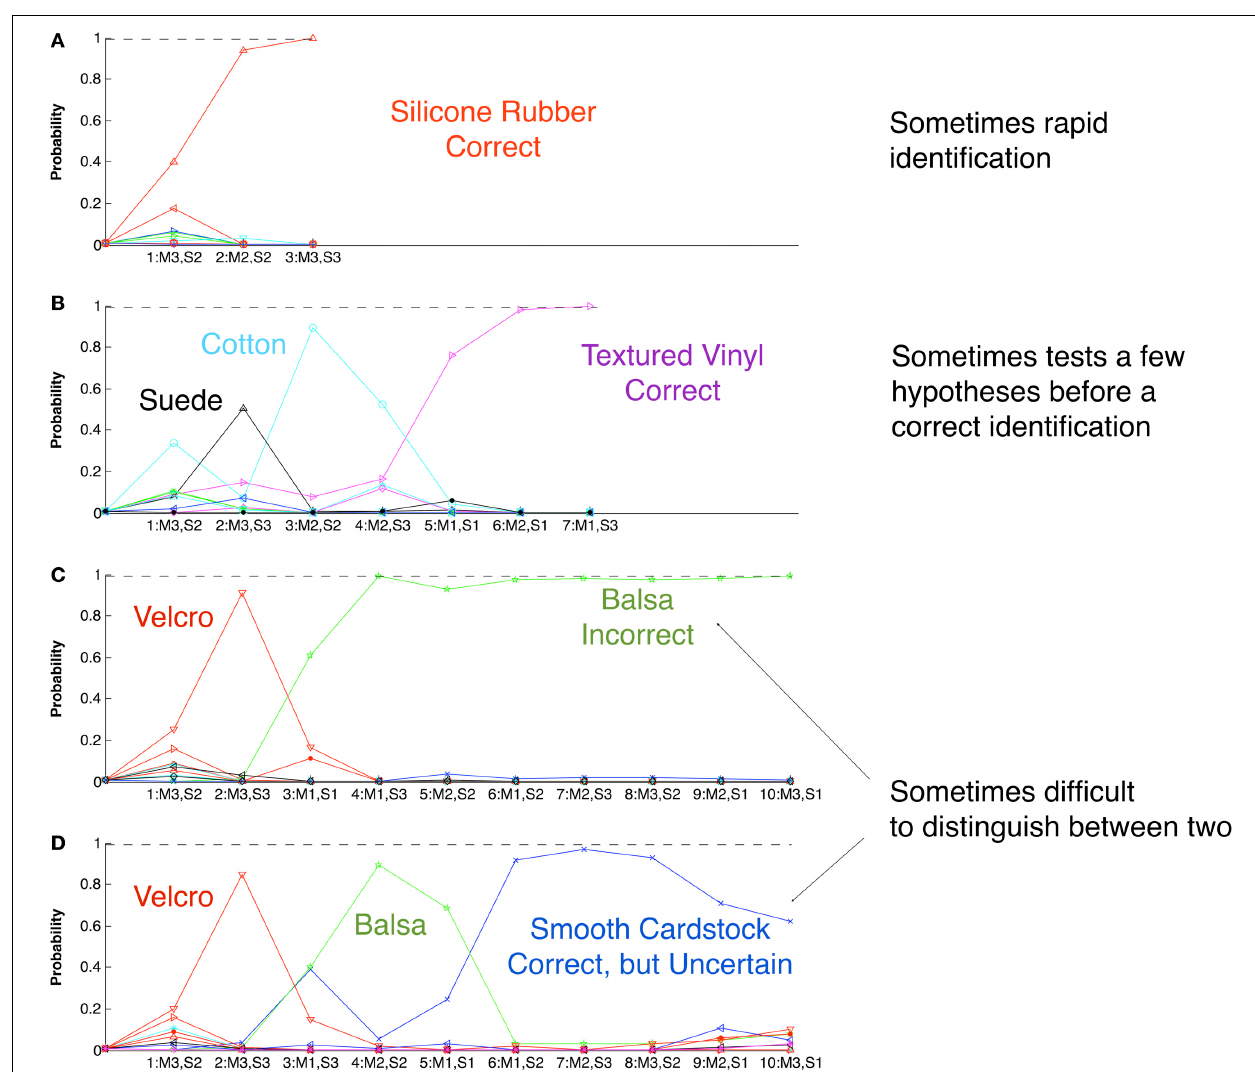
FIGURE 4 | The performance of the texture identification robot using Bayesian Exploration with a database of 117 textures previously explored with three exploratory movements (M1–3) and characterized according to three sensory percepts (S1–3). At the beginning of all four trials (A–D) with unknown samples, the probability of any specific texture (ordinate) is 1/117. Each successive movement and sensory percept (numbered pairings along abscissa) is selected according to its potential to disambiguate the currently likely possibilities (see Figure 3 ), resulting in a new set of probabilities for each remaining viable candidate (colored lines). Similar to humans, the number and